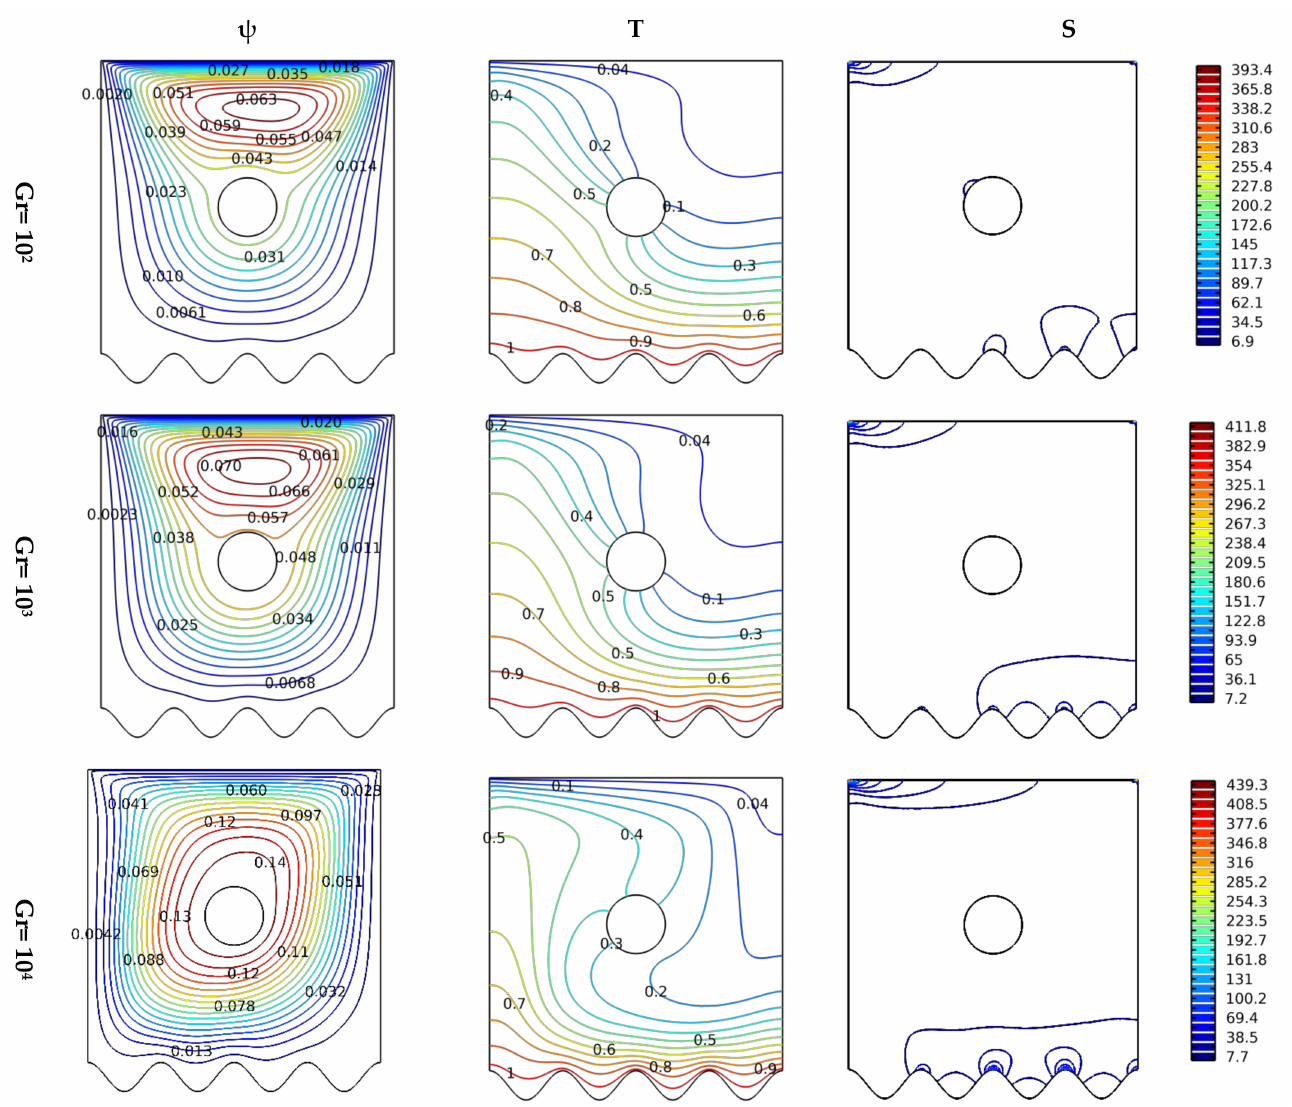
Figure 4. Distribution of streamlines, isotherms, and isentropic contours for various Gr numbers at N = 8, Ha = 0, and Da = 10 − 2